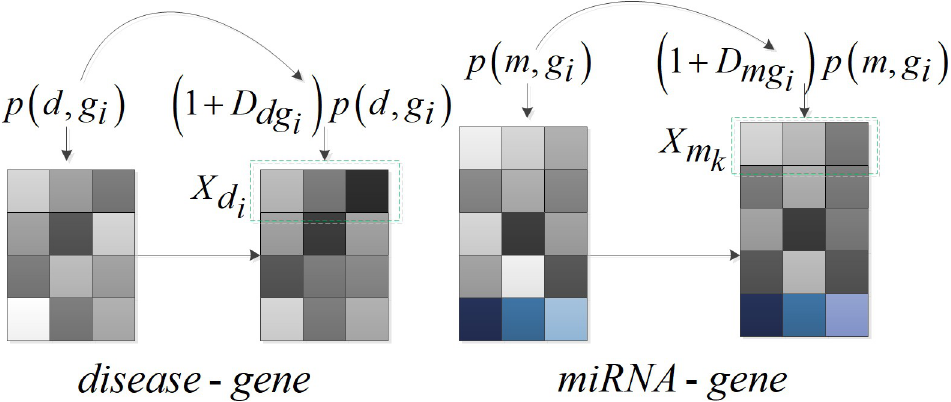
Fig 3. Weighted feature processing for disease-gene and